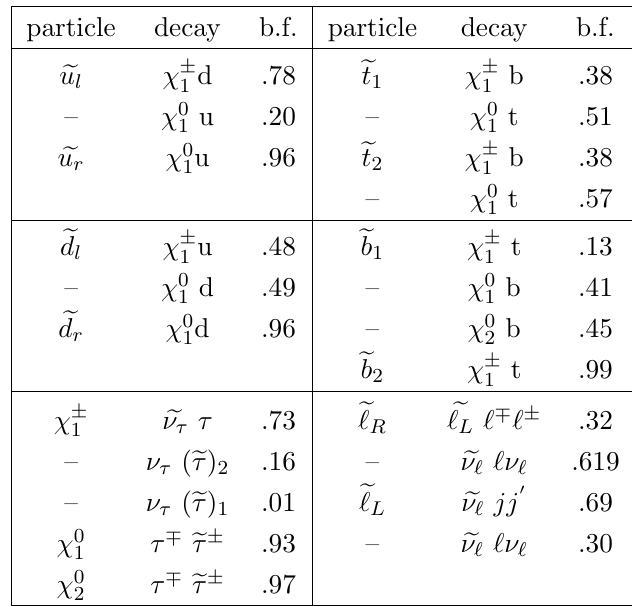
Table 5 . Branching fractions for the most probable decay in a model with benchmark mass spectrum with sneutrino